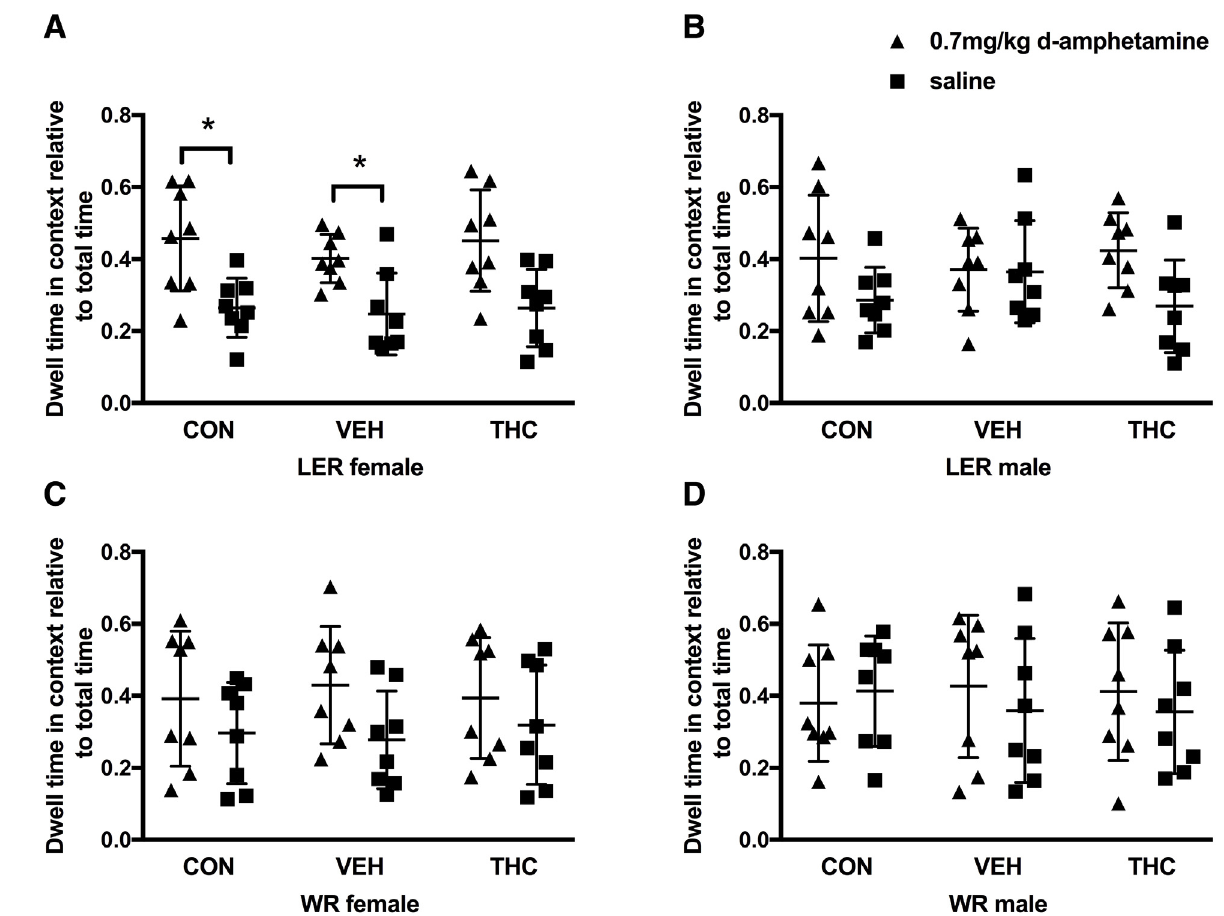
Figure 2. CPP to 0.7mg/kg d-amphetamine in THC exposed adolescent LER and WR male and female rats. Preference for A ) LER females, B ) LER males, C ) WR females and D ) WR males. * p<0.05.